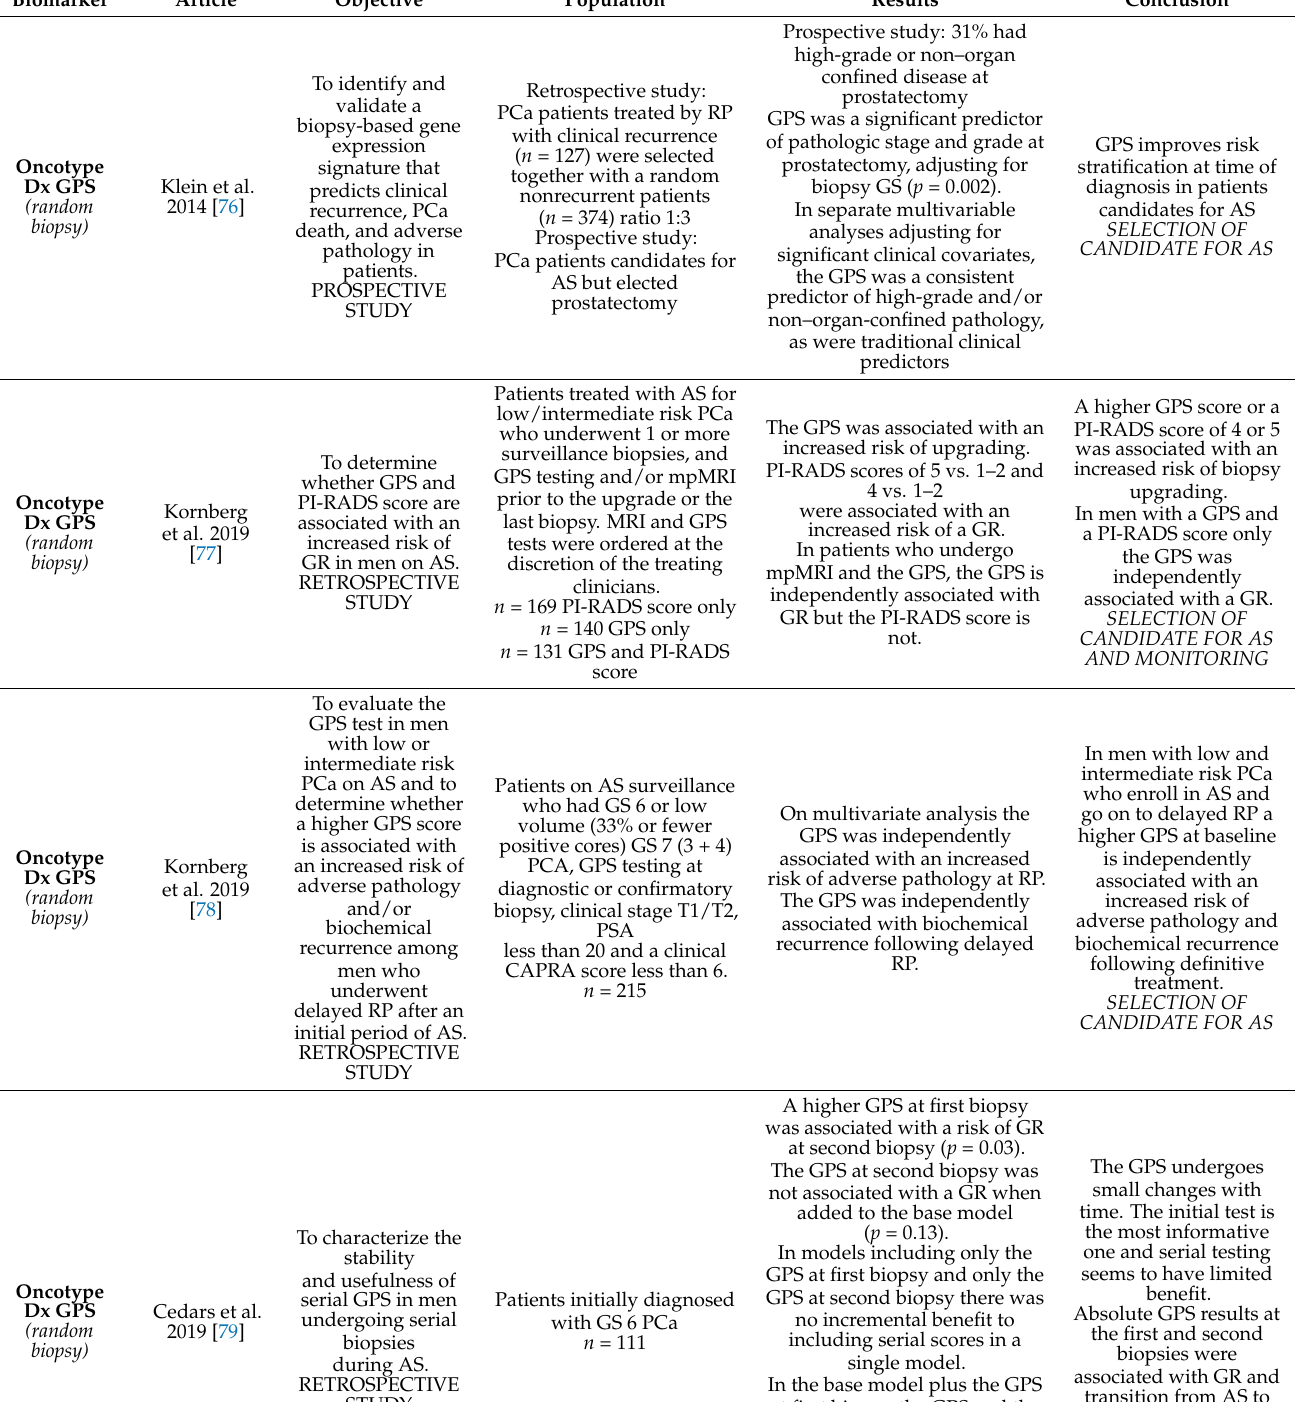
Table 3. Tissular